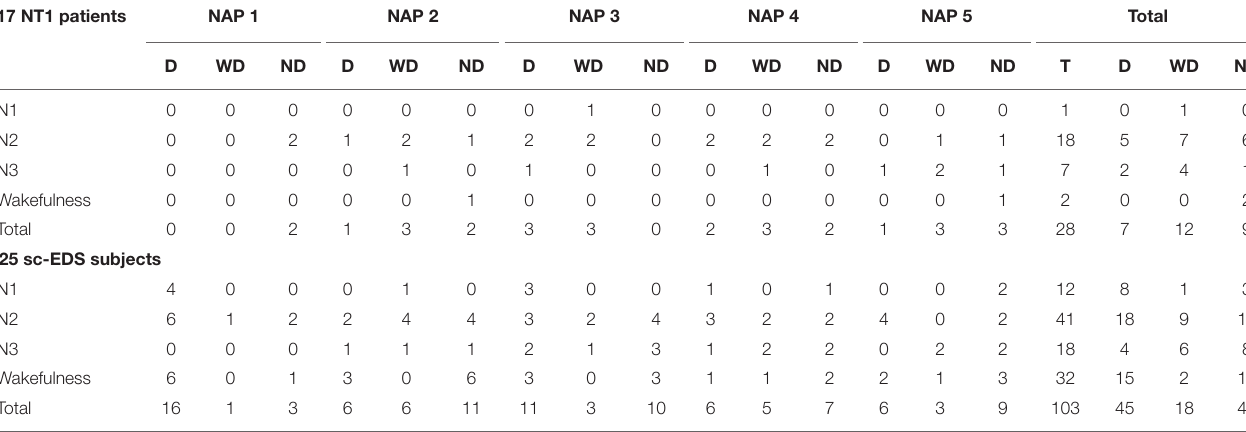
TABLE 3 | Sleep stage or wakefulness at the end of MSLT trials resulting in NREM naps with dream, white dream, or no dream. 17 NT1